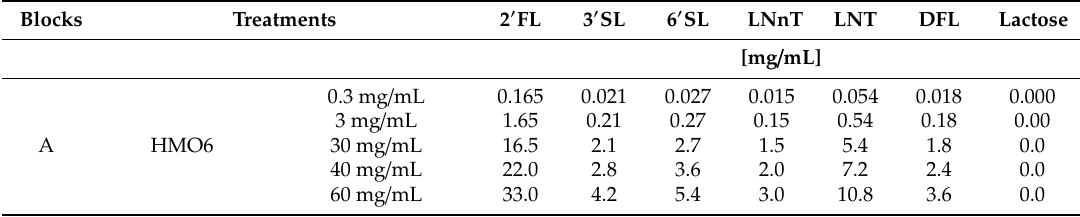
Table 1. HMO concentration [mg / mL] and composition of the 49 treatments.